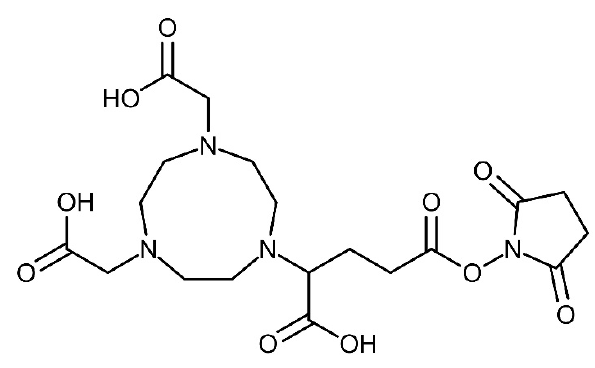
Figure 3. Chemical structure of NODAGA ‐ NHS.